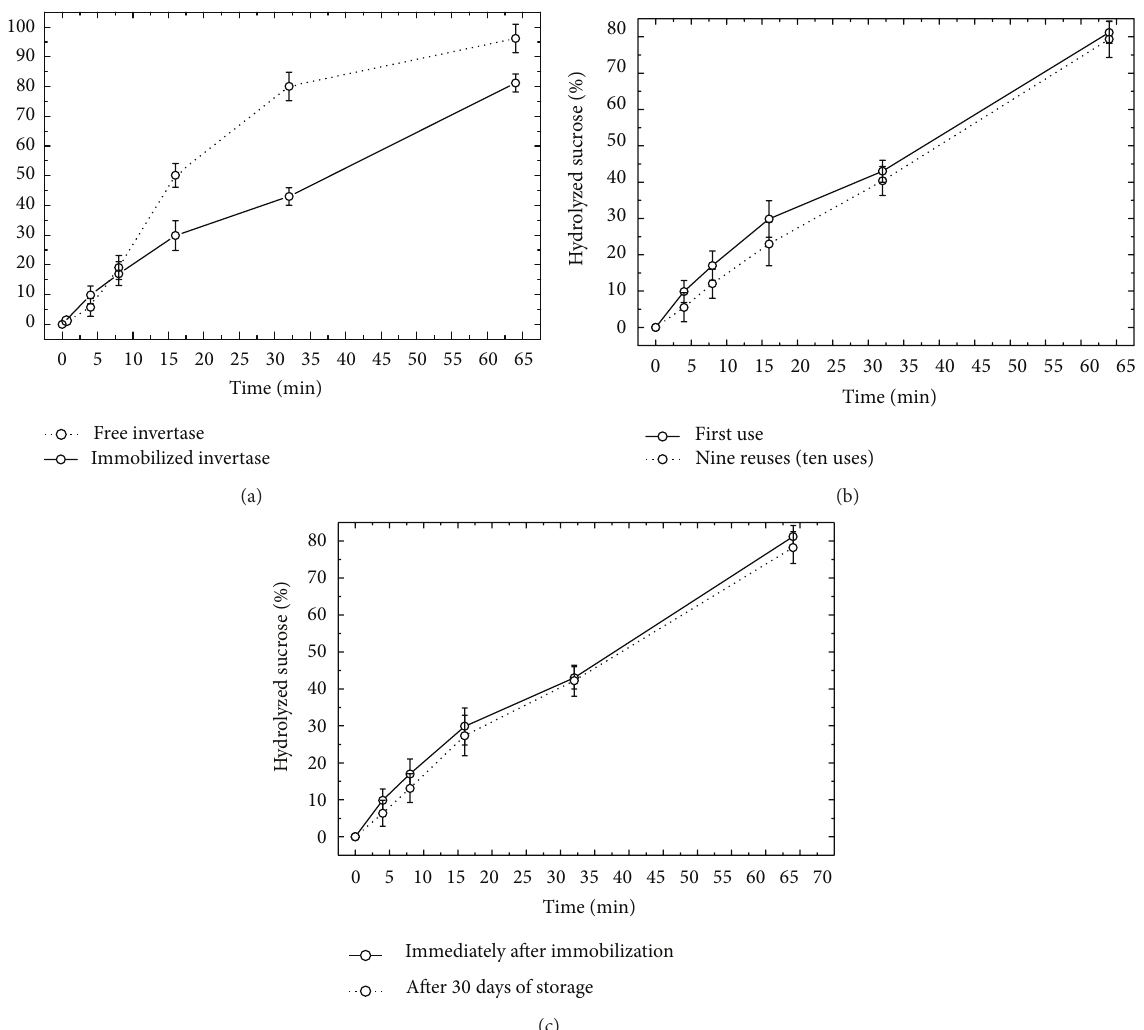
Figure 5: Results of assays of hydrolysis of the sucrose with the C318-invertase, after 65min. (a) Comparative effect between free and immobilized invertase on the percentage of hydrolysed sucrose (mean ± standard deviation). (b) Effect of 9 reuses (10 uses) on the percentage of hydrolyzed sucrose (mean ± standard deviation). (c) Effect of storage (30 days) on the percentage of hydrolyzed sucrose (mean ± standard